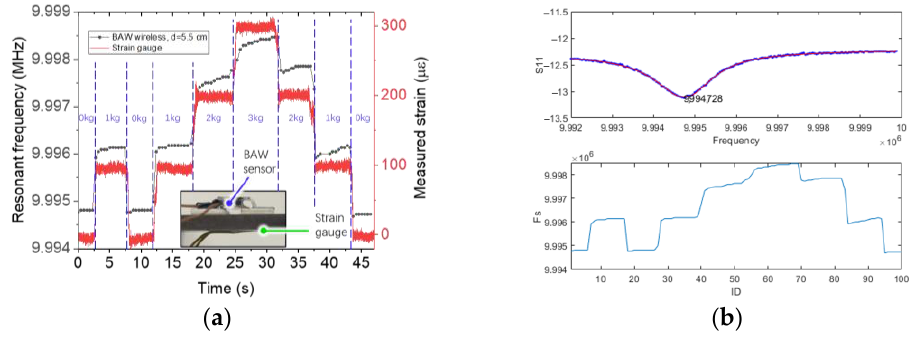
Figure 11. The time response of a BAW passive wireless sensor. ( a ) The signals of a BAW passive wireless sensor and a strain gauge as a function of time. ( b ) A screenshot of the real-time strain monitoring and signal processing interface. We measured 101 data points in 49 s.